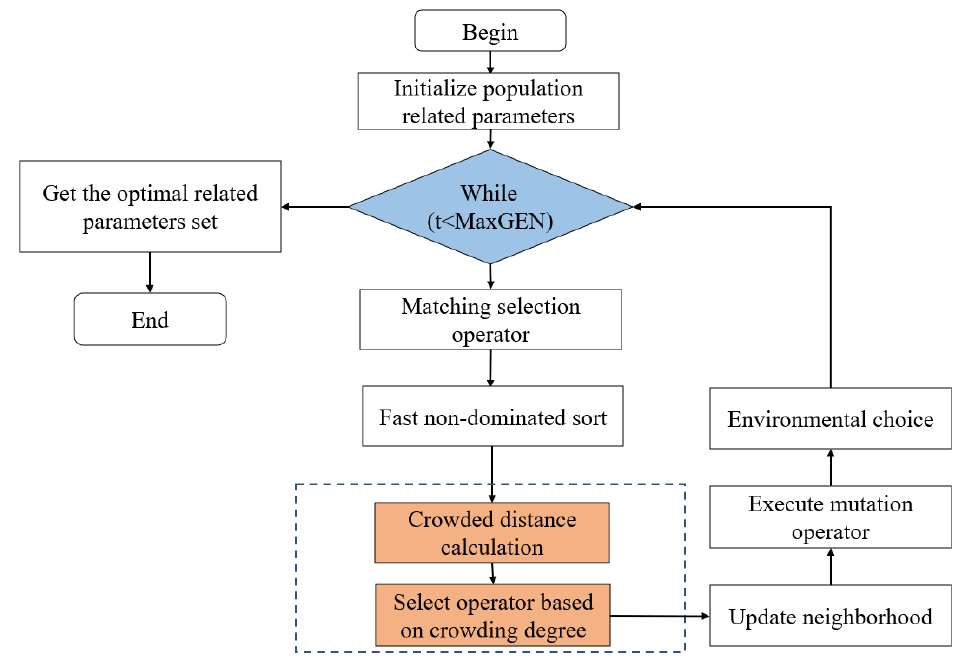
Figure 9. The framework of an SR-NSGA-2.